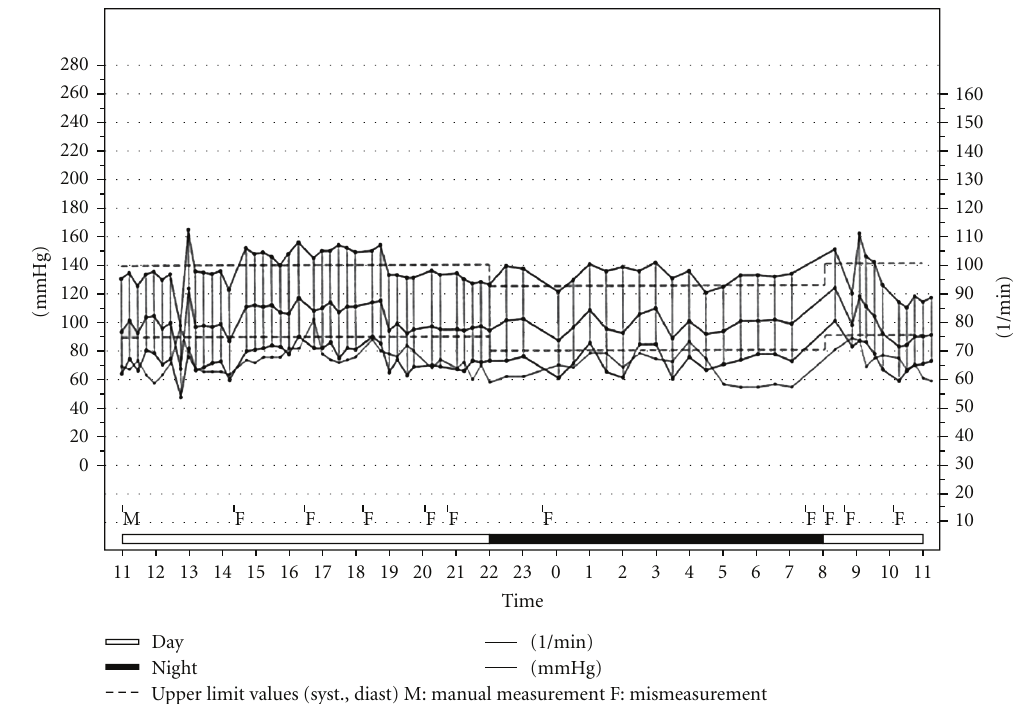
Figure 1: Example of a 24-hour ambulatory blood pressure recording in a patient with Parkinson’s disease. Table 3: Autonomic test results (Schellong test). Patients with PD Variable n = 40